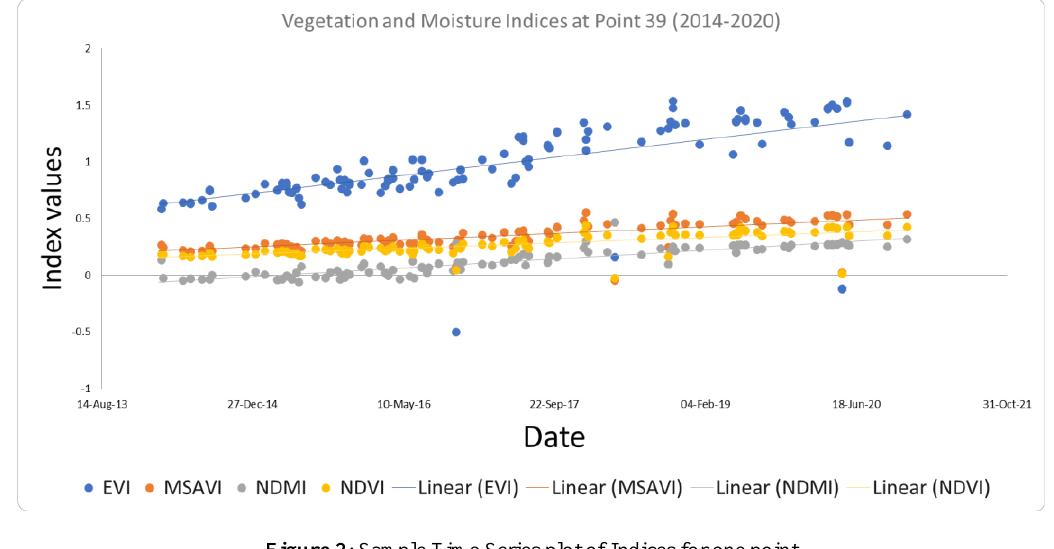
Figure 2 : Sample Time Series plot of Indices for one point